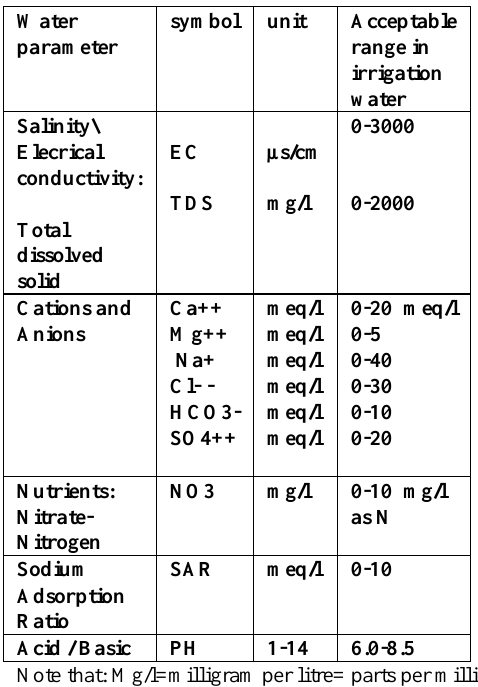
Table(3) laboratory determination needed to evalute